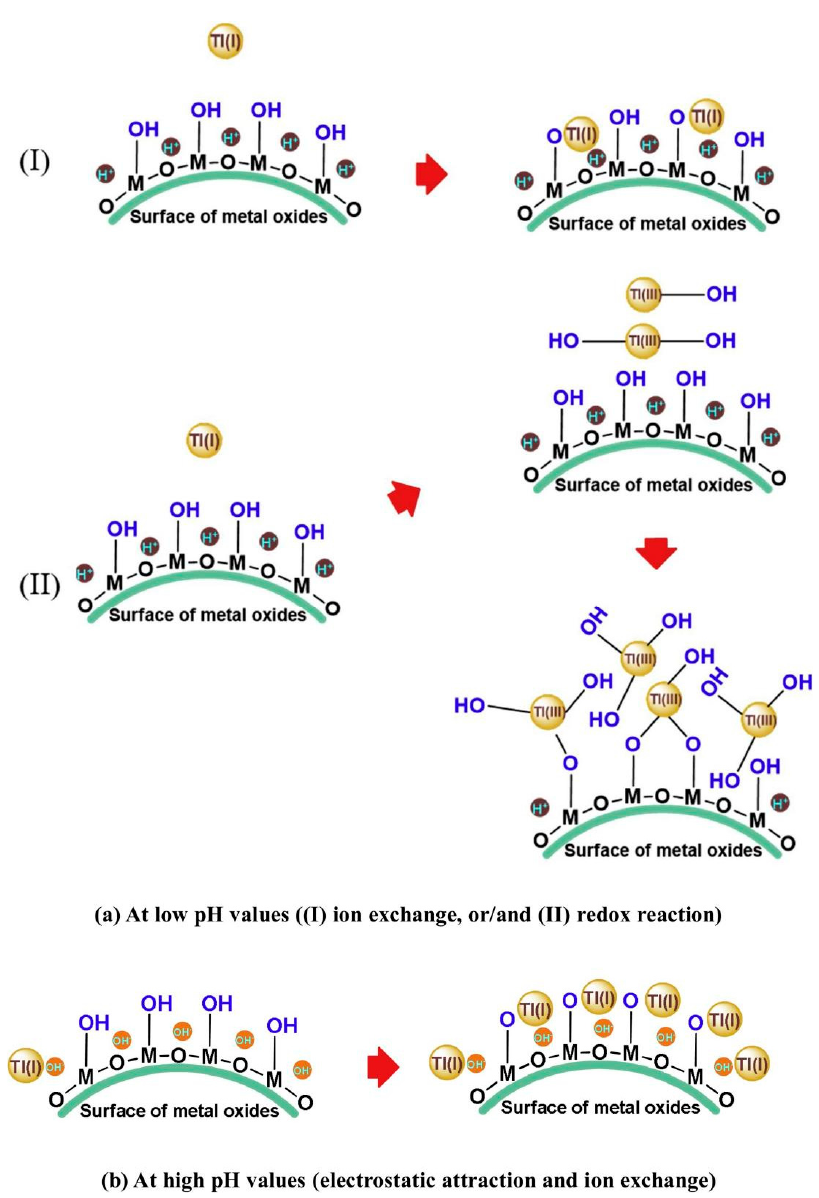
Figure 10. Schematic diagram of the effect of pH on the adsorption of Tl(I) by metal oxides: ( a ) At low pH; ( b ) At high pH [21].